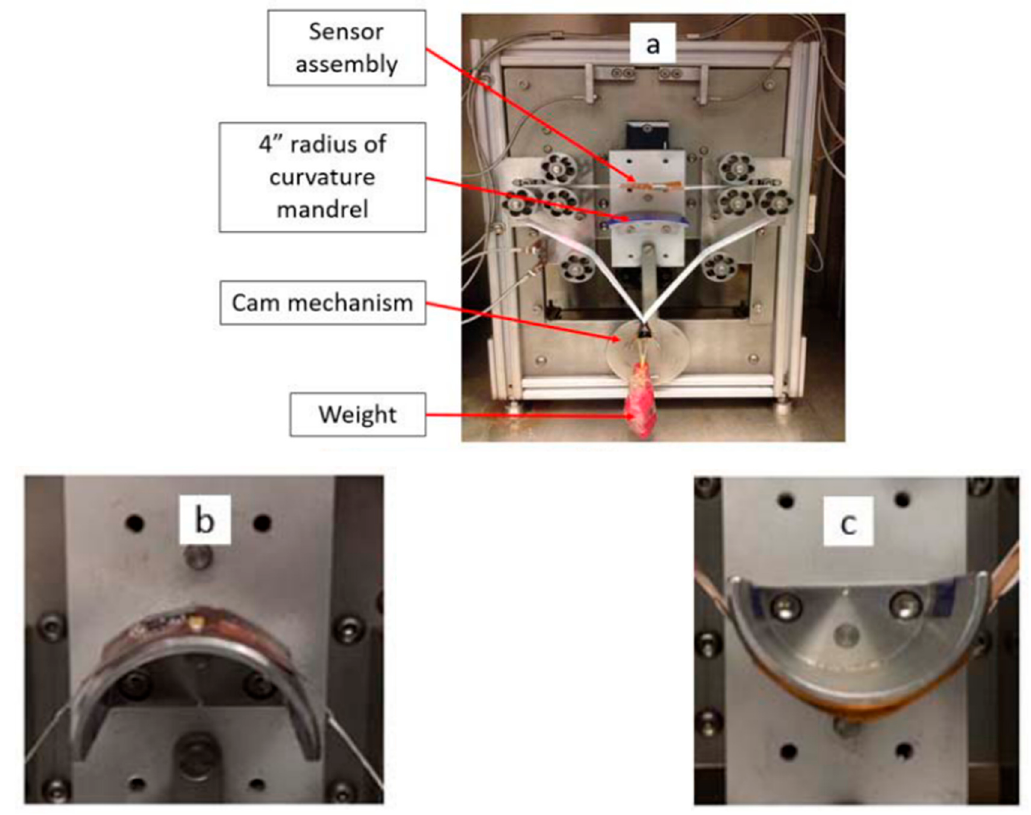
Figure 15. ( a ) Dynamic push to flex bend-testing setup; ( b ) components on the top are in tensile and ( c ) in compression (reproduced with permission) [102].